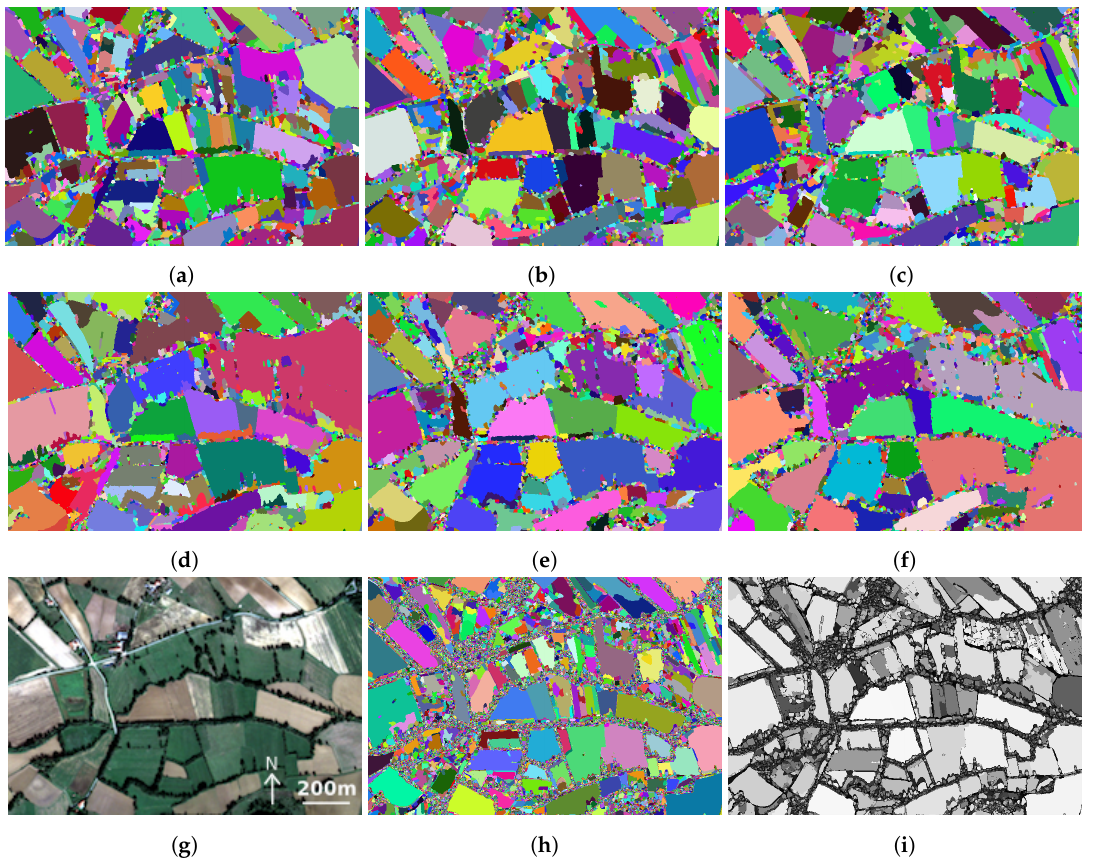
Figure 2. From input segmentations to confidence map: input segmentations ( a – f ) extracted from a single data source ( g ), their intersection into super-pixels ( h ) and the resulting confidence value map ( i ). Pseudo-colors are randomly generated from region labels providing one different color per region. In the confidence value map, brighter color corresponds to a higher confidence score, and darker color indicates a lower confidence score. The single data source ( g ) was extracted from an optical Pleiades multispectral image acquired on 12 October